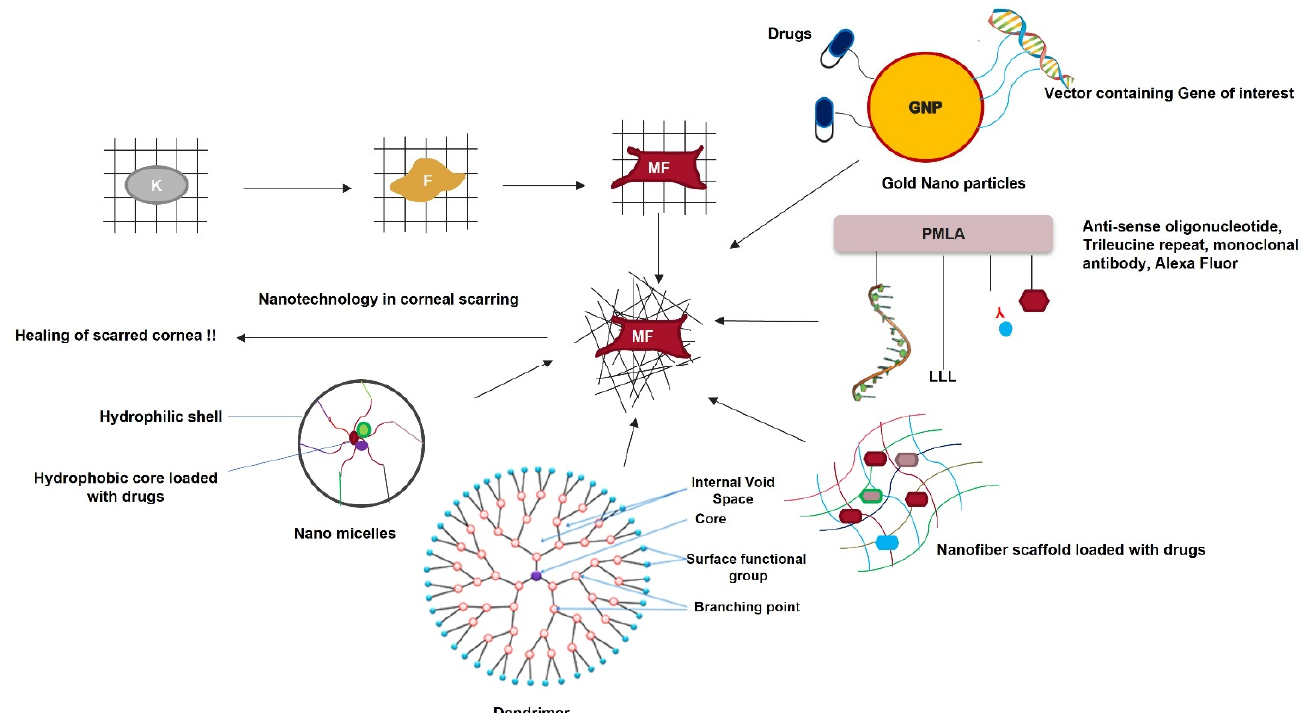
Figure 7. Nanotechnology as a therapeutic tool for reviving scarred corneas. Keratocytes transform into fibroblasts and then into myofibroblasts in the presence of TGF- β . This disrupts the highly or-